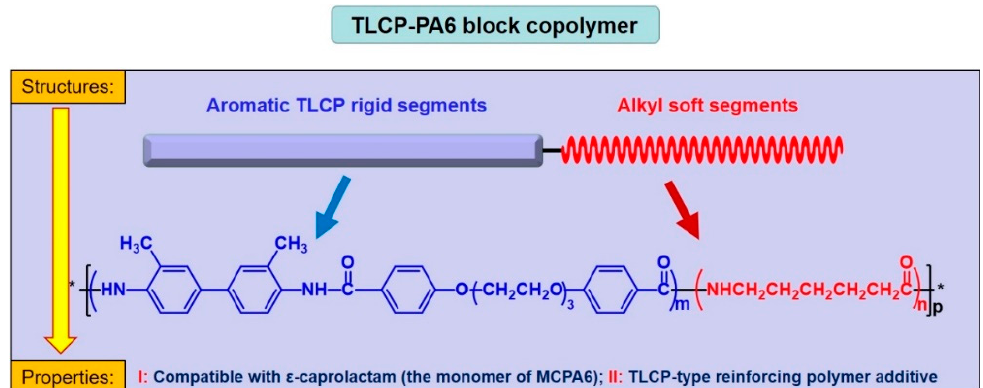
Figure 1. Chemical structure and properties of TLCP-PA6 block copolymer in this work.